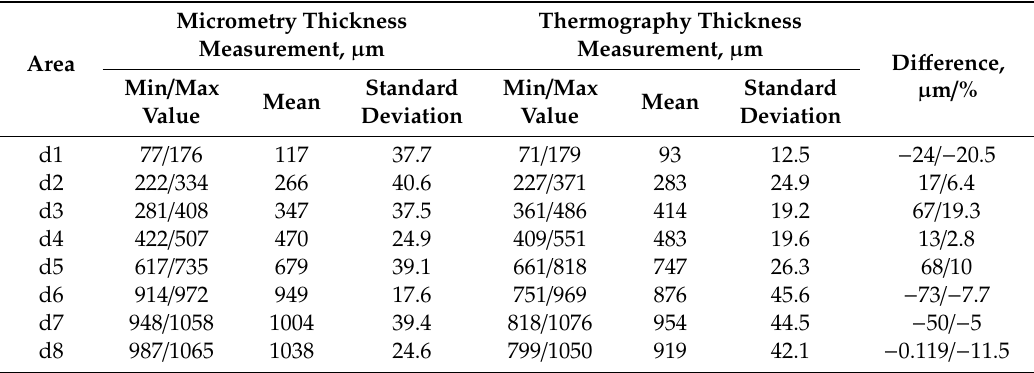
Table 2. Coating thickness measurement